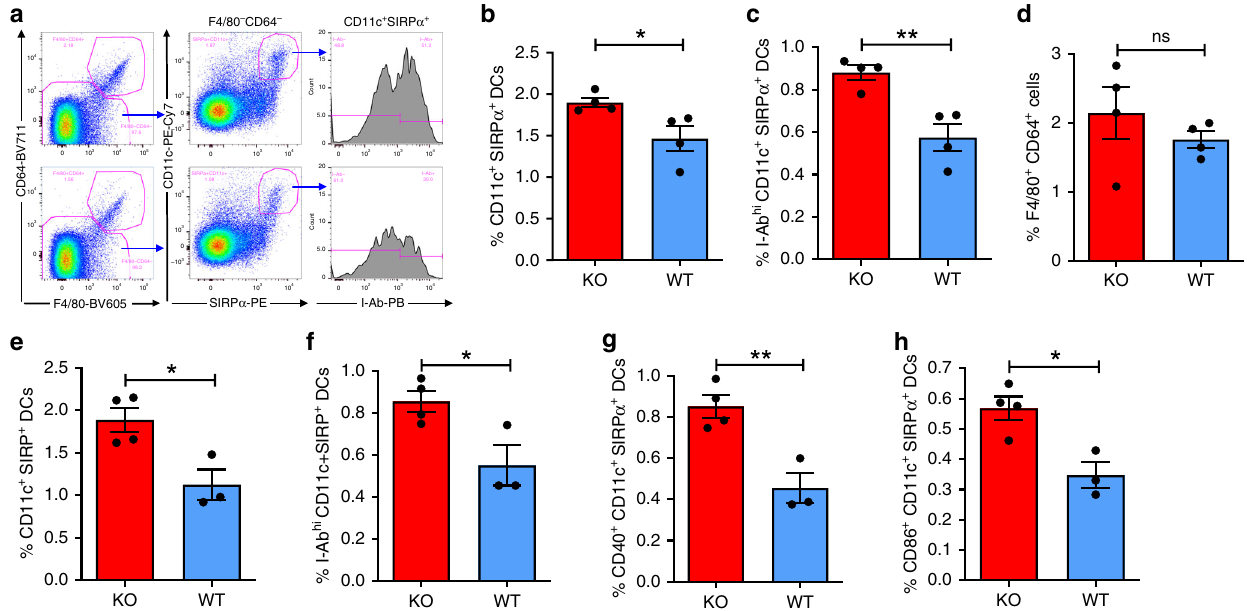
Fig. 5 CD47KO tumor vaccination induces CD11c + SIRP α + DC activation. Spleen cells were harvested 24h ( a – d ) or 60h ( e – h ) after vaccination with 2.5 × 10 6 irradiated WT or CD47KO B16F0 cells and analyzed for SIRP α + DCs by fl ow cytometry. a Representative fl ow cytometry pro fi les showing expression of F4/80 and CD64 in spleen cells (left), SIRP α and CD11c expression in gated F4/80 − CD64 − cell population (middle), and I-Ab expression in gated SIRP α + CD11c + (F4/80 − CD64 − ) DCs (right). Cells from CD47KO and WT tumor cell-vaccinated mice are shown in the top and bottom,